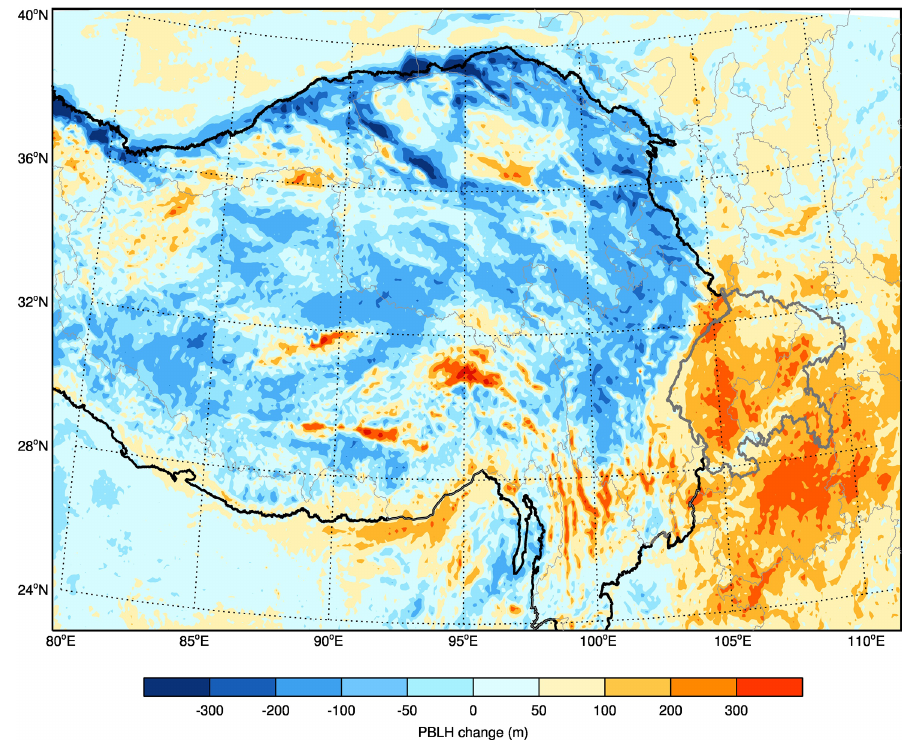
Figure 9. Spatial change in the PBL height induced by 2 ◦ C warming over the Tibetan Plateau. The positive values show the PBL height increases while the negative values show the PBL height decreases.